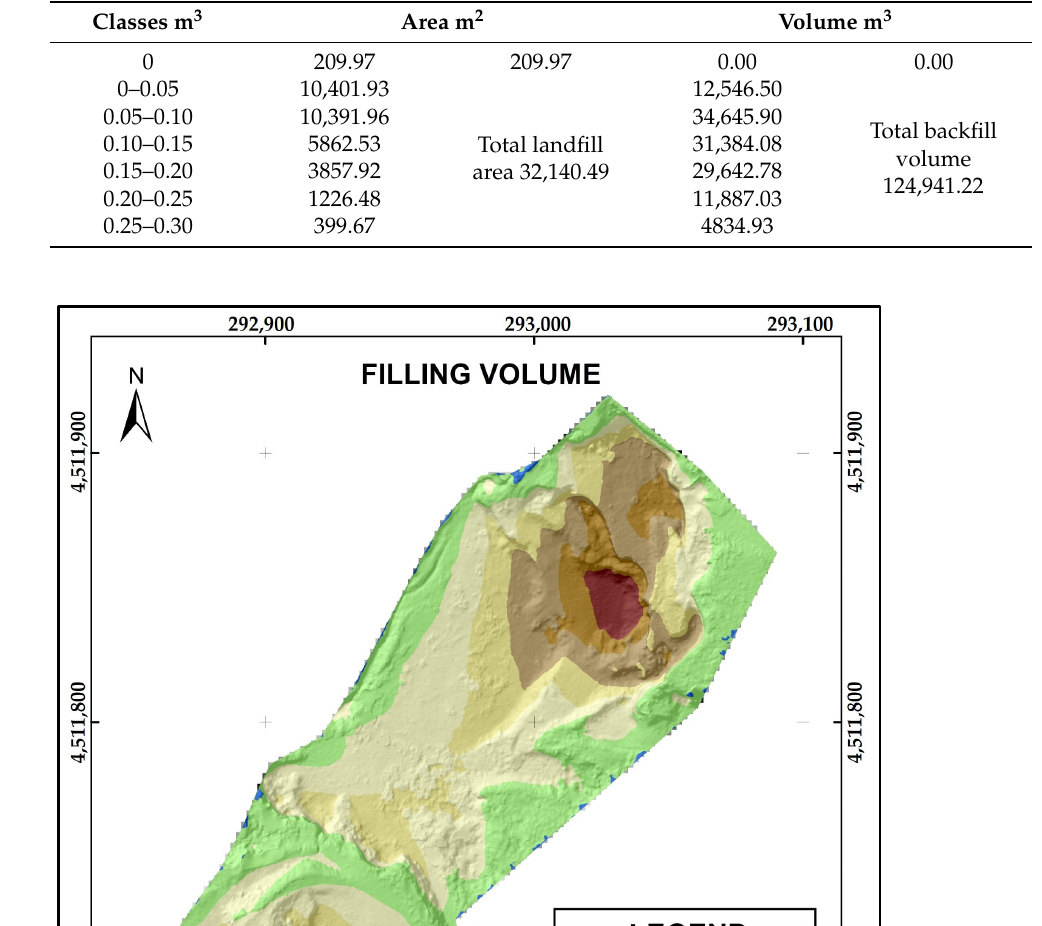
Table 2. Volumetric calculation by the intensity of volume class.